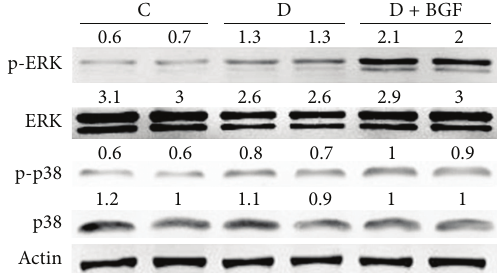
Figure 4: BGF treatment enhanced ERK1/2 phosphorylation in the kidney of mice. The p38 activity was not sensitive to BGF treatment.